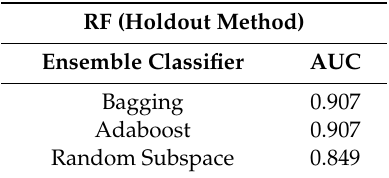
Table 11. AUC evaluation of ensemble with RF base